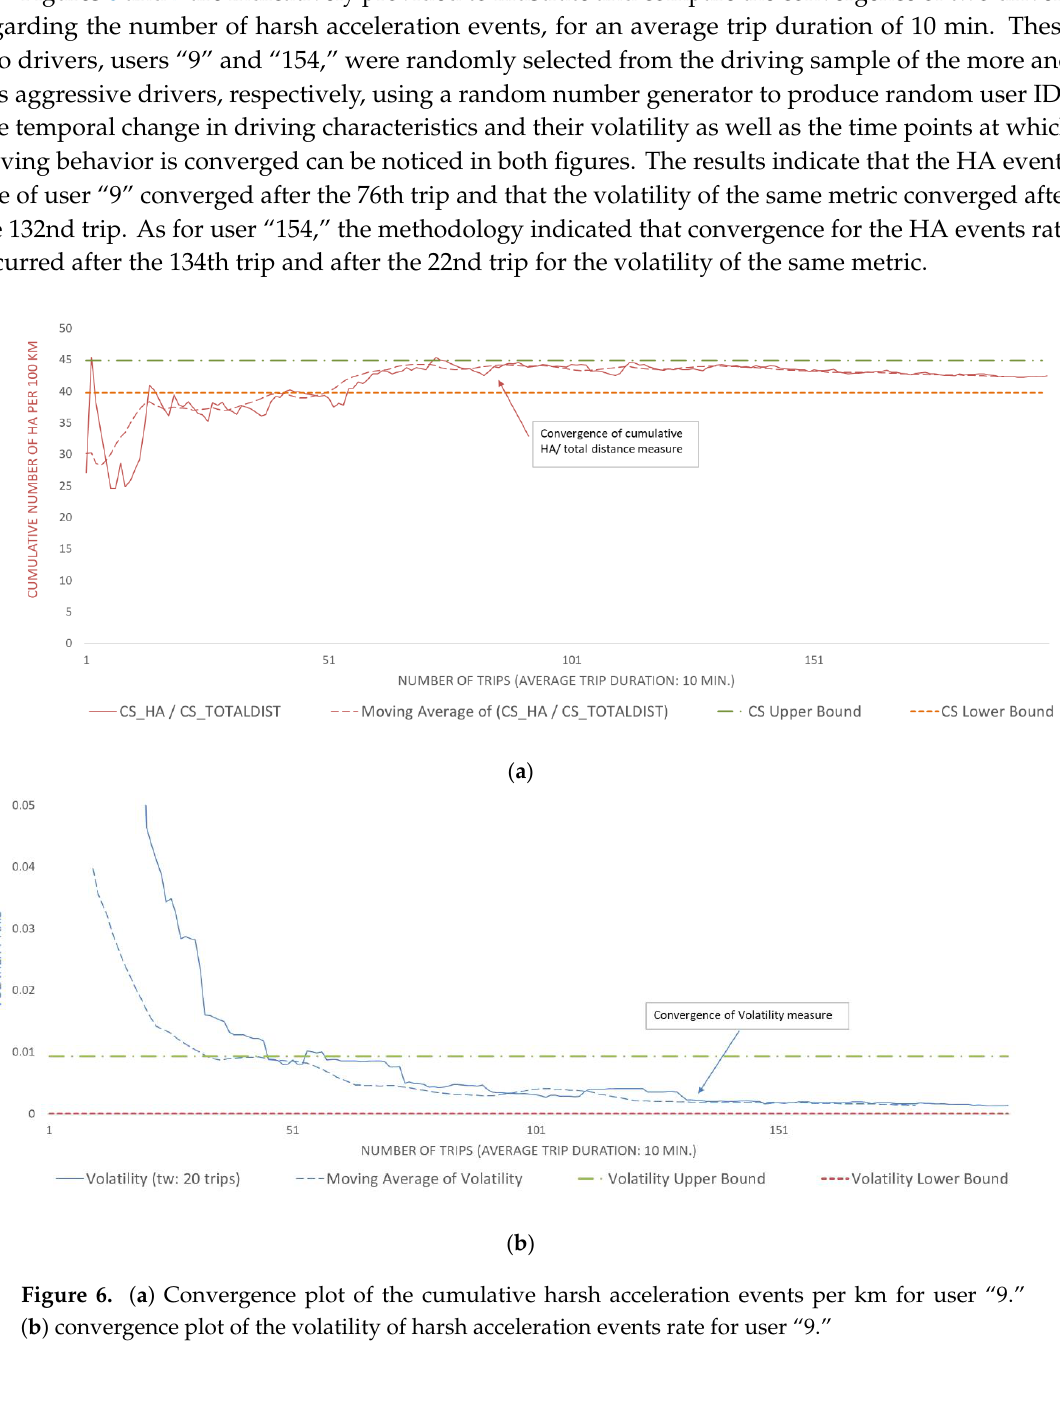
Table 3. Cumulative table of percentages of drivers and their critical characteristic for each duration.